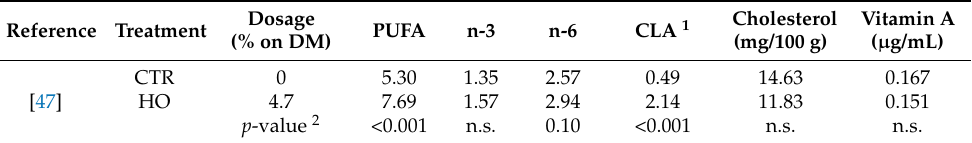
Table 8. Effect of hempseed oil (HO) on fatty acids, cholesterol and vitamin A of goat